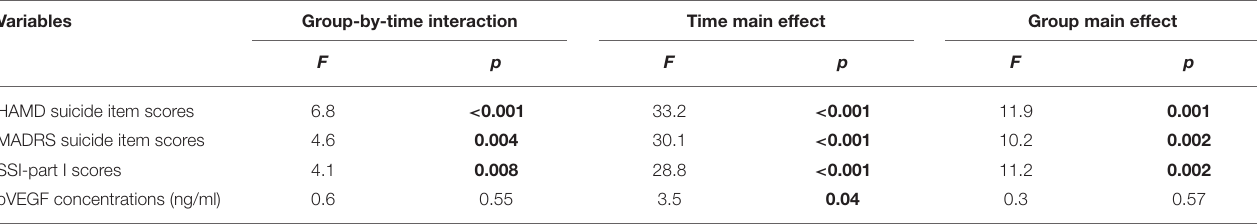
TABLE 2 | Comparison of suicidal ideation scores and pVEGF concentrations between antisuicidal responders and non-responders in depressed patients with suicidal ideation using linear mixed model analysis.